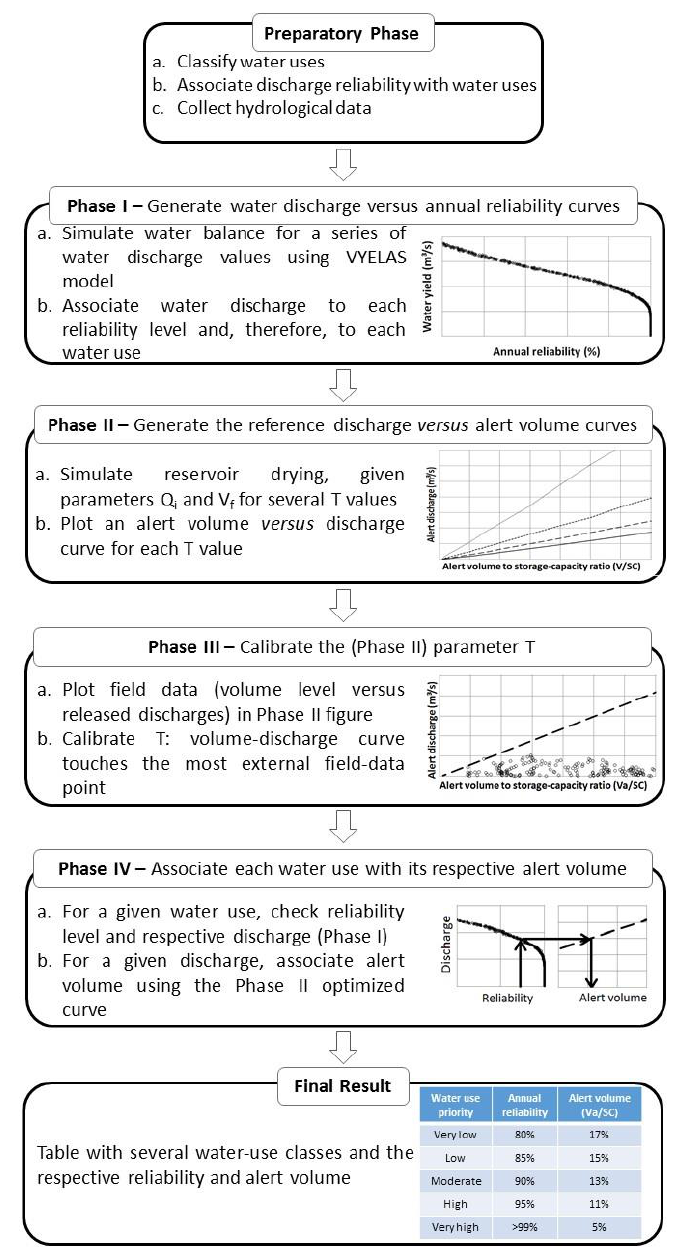
Figure 2. Flow chart of the proposed methodology. Q i means input discharge, V f is the final reservoir volume after depletion, and T is the depletion